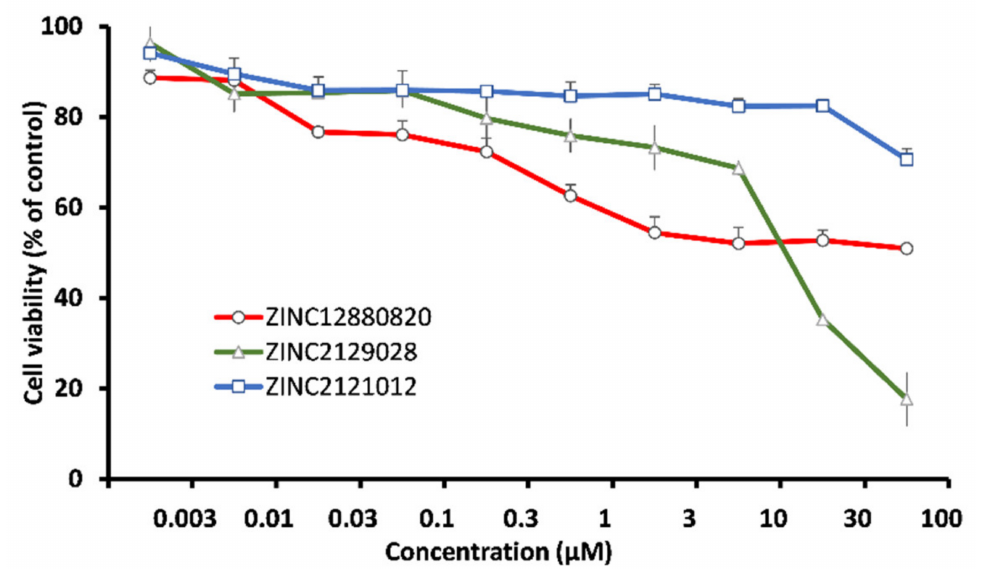
Figure 8. Dose-response curves of the hit compounds against MRC-5 cells as determined by the resazurin assay. The data are representing mean values ± SD of three independent